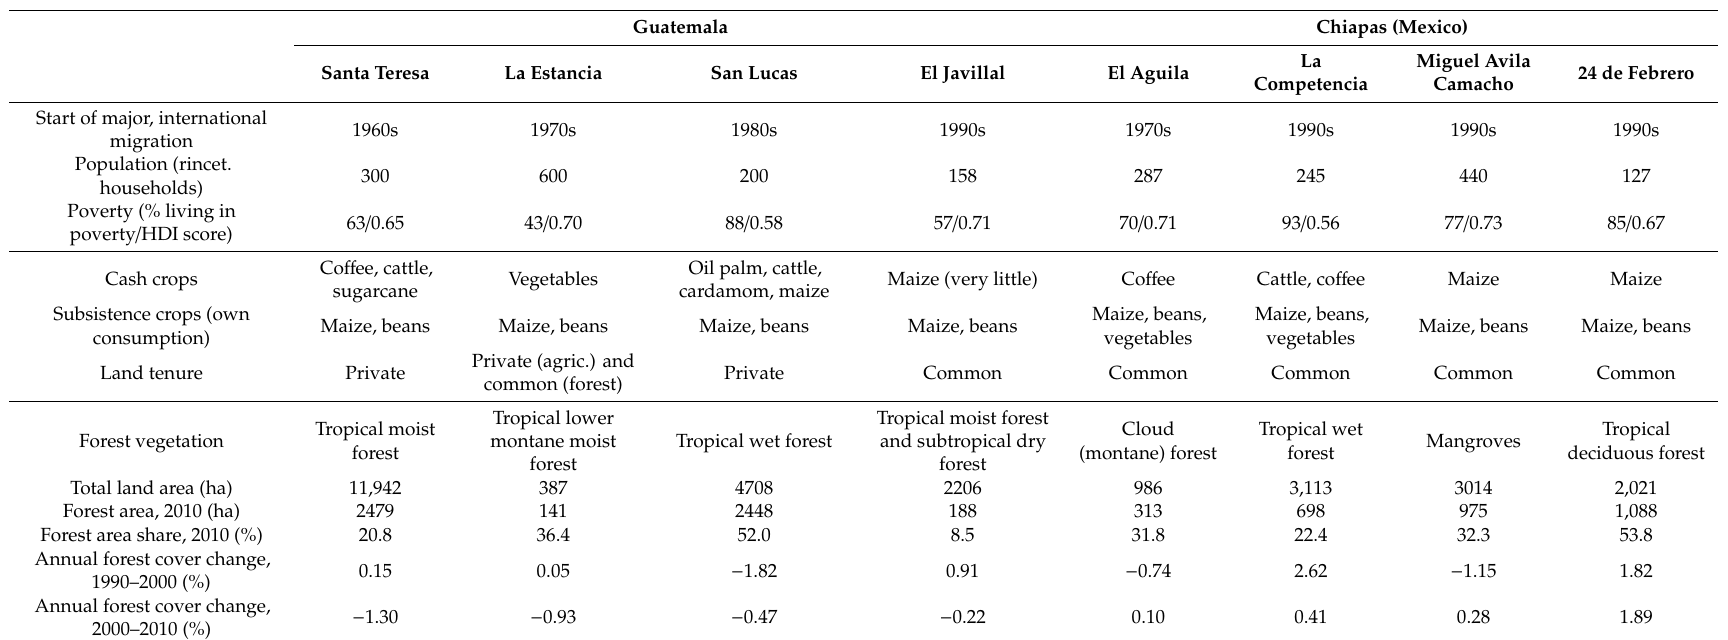
Table 1. Key figures for the eight study